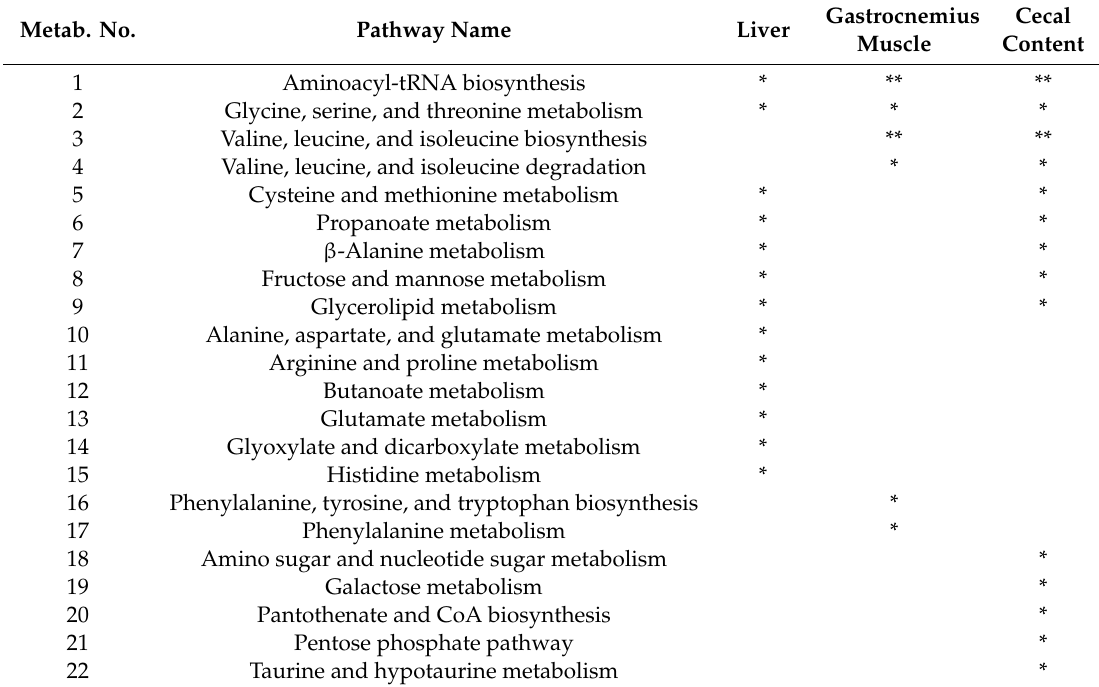
Table 5. Potential metabolic pathways a ff ected by dietary protein sources. Metab. No.